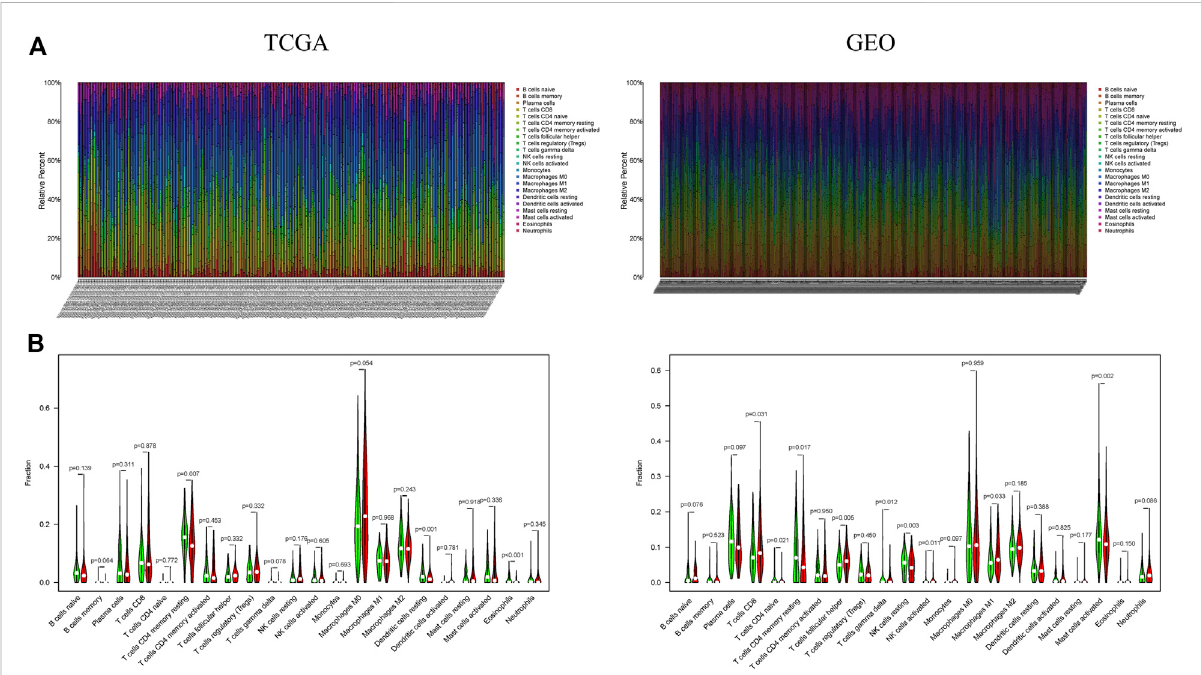
FIGURE 6 Adifferenceinimmunecelllandscapebetweenlowandhighferroptosis-associatedrisksinCRCpatients. (A) Relativedistributionof22immune cells in all samples from TCGA and GEO cohorts; (B) The contents of immune cells in low- and high-risk groups. The low-risk group is indicated in green, the high-risk group is indicated in